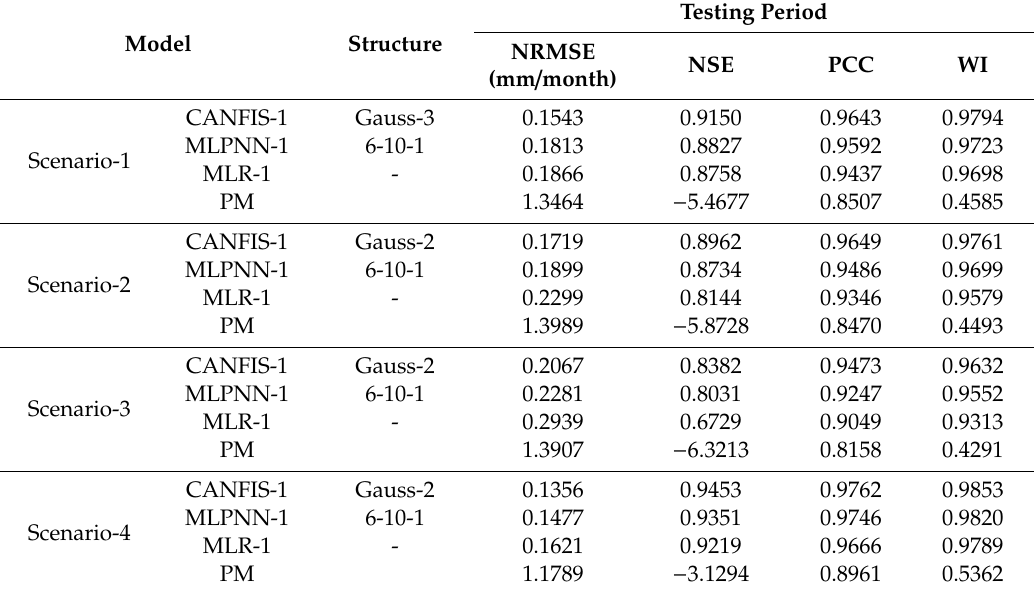
Table 6. NRMSE, NSE, PCC, and WI values of the CANFIS, MLPNN, and MLR models during the testing period at Nagina station under four di ff erent